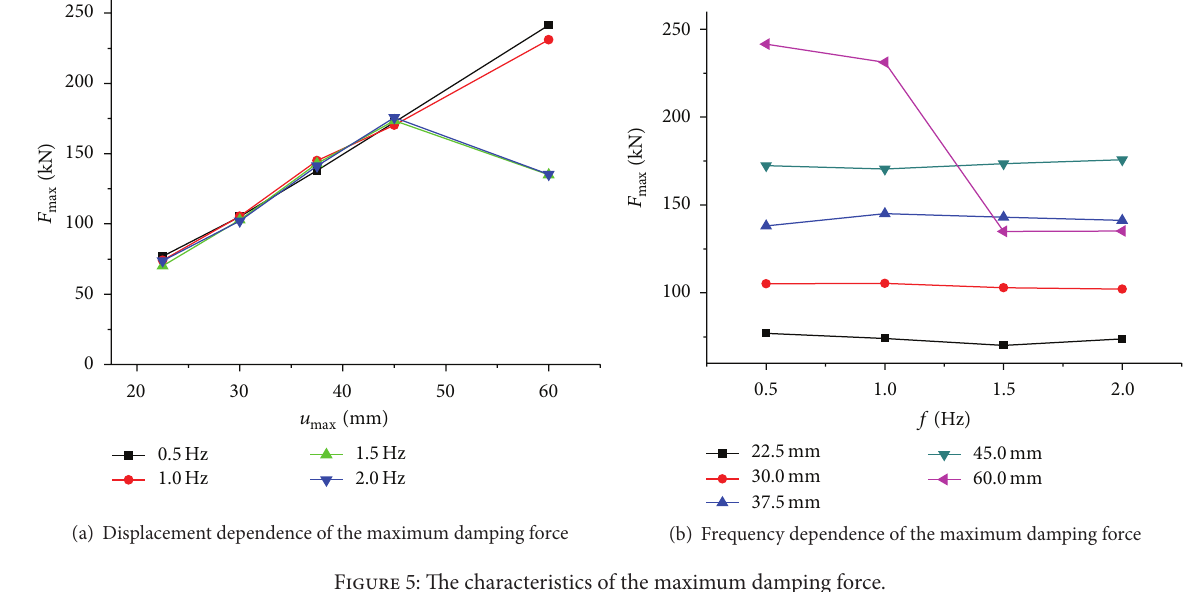
Figure 5: The characteristics of the maximum damping force.